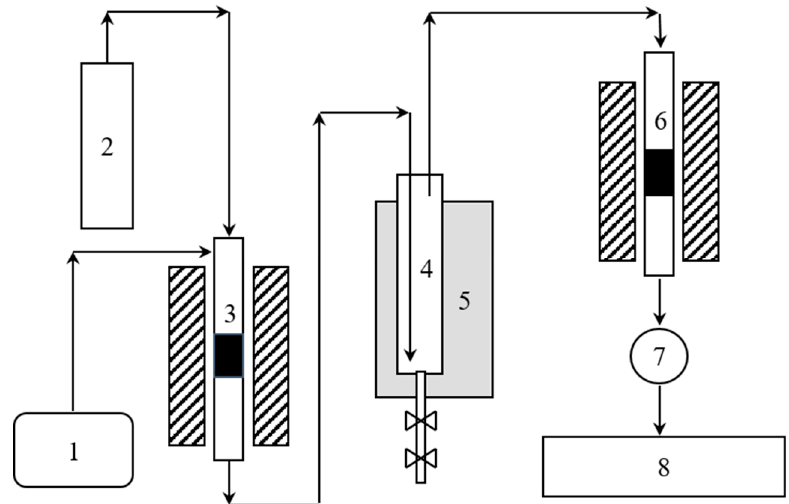
Figure 8. Illustration of reaction process for the production of higher olefins from hydrous ethanol.